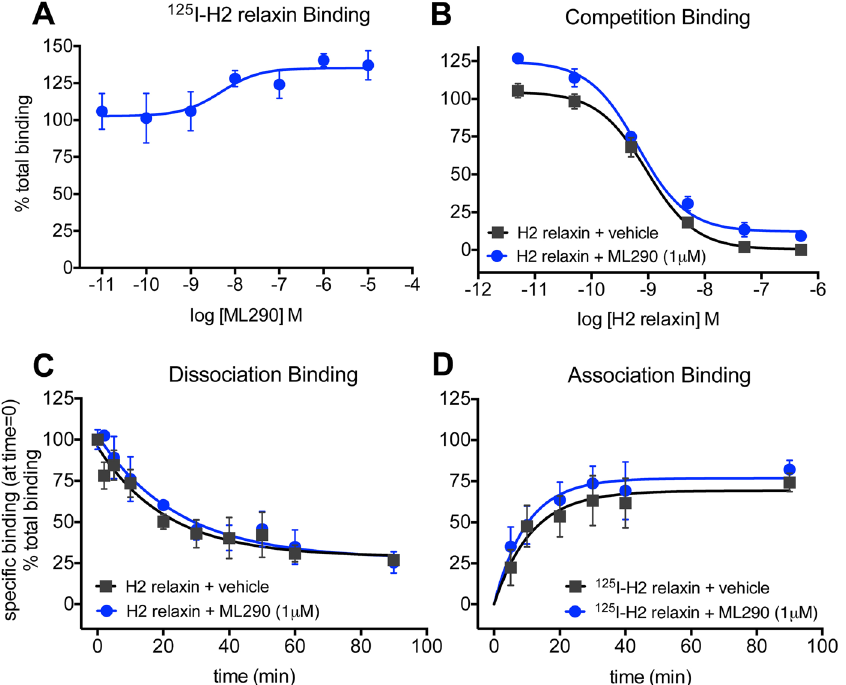
Figure 1. ML290 and binding of 125 I-H2 relaxin to RXFP1 stably expressed in HEK293 cells. In ( A ) co- incubation with ML290 (90 min), increased total binding of 125 I-H2 relaxin to RXFP1 in a